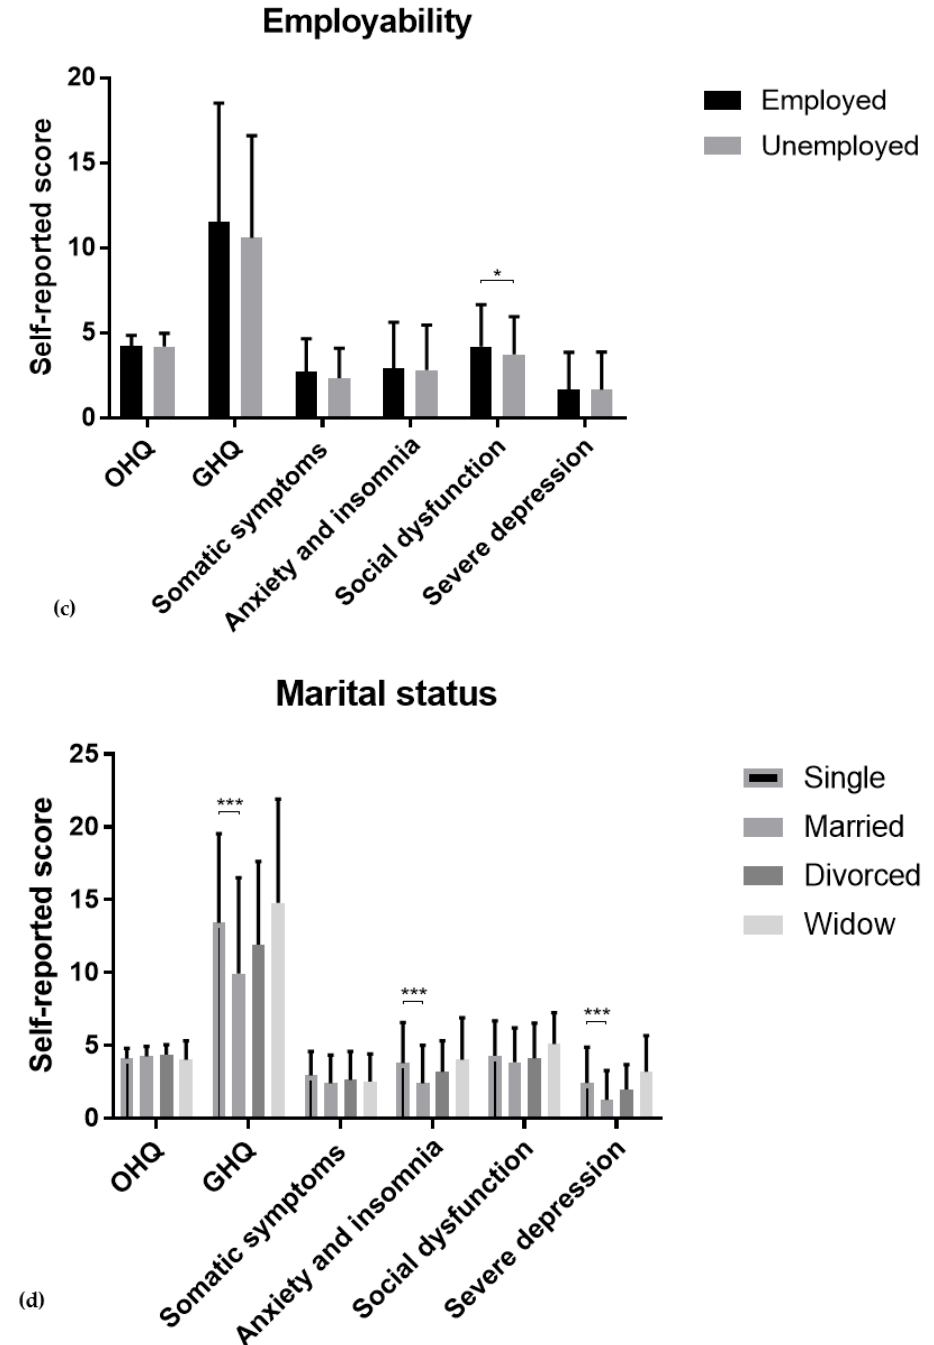
Figure 1. Bar charts for ( a ) Age group, ( b ) Education, ( c ) Employability and ( d ) Marital status rep- resent Mean ± SD . * p < 0.05, ** p < 0.005, *** p < 0.001. represent Mean ± SD . * p < 0.05, ** p < 0.005, *** p <